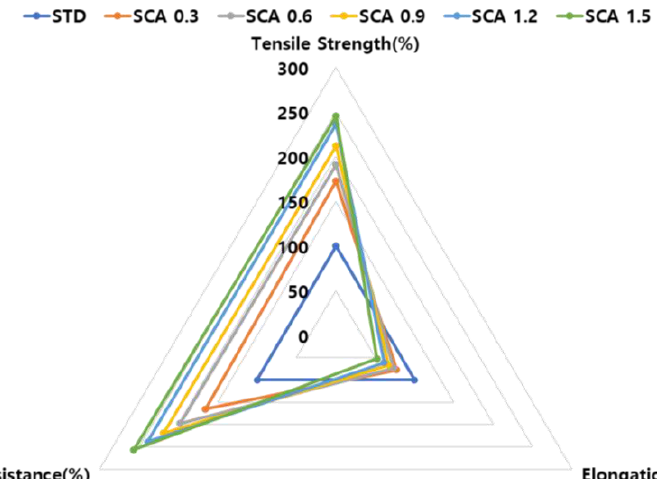
Figure 9. Strength increase/decrease rate according to the amount of SCA input.